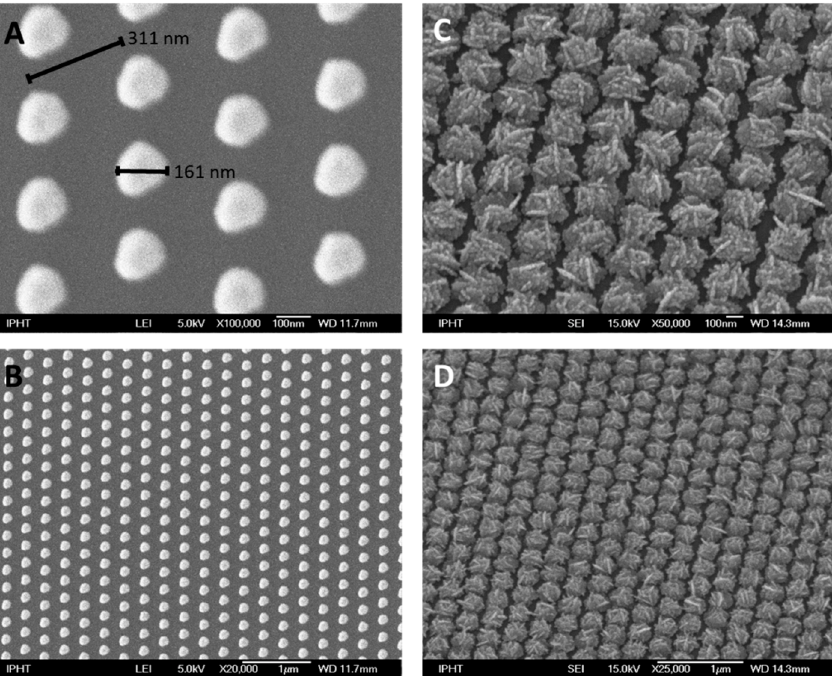
Figure 1. SEM images of the gold island template structure ( A , B ) and the corresponding TopUp silver structure after self-organized silver deposition ( C , D ).